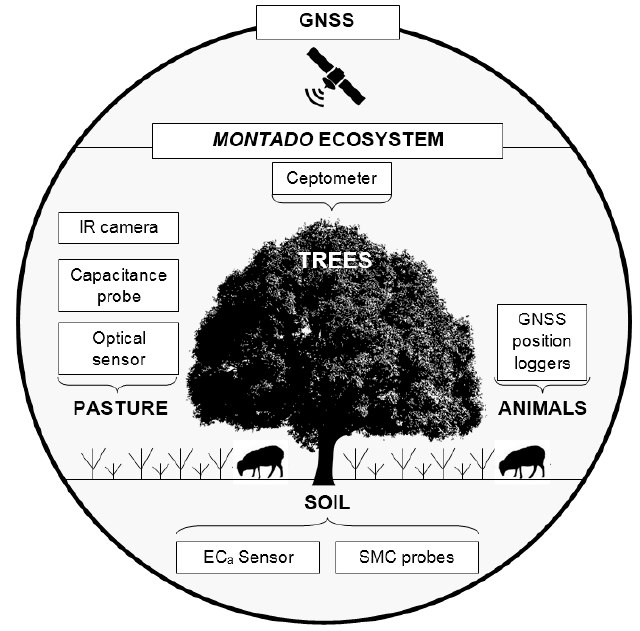
Figure 1. Proximal sensors used in this study for monitoring the montado ecosystem.